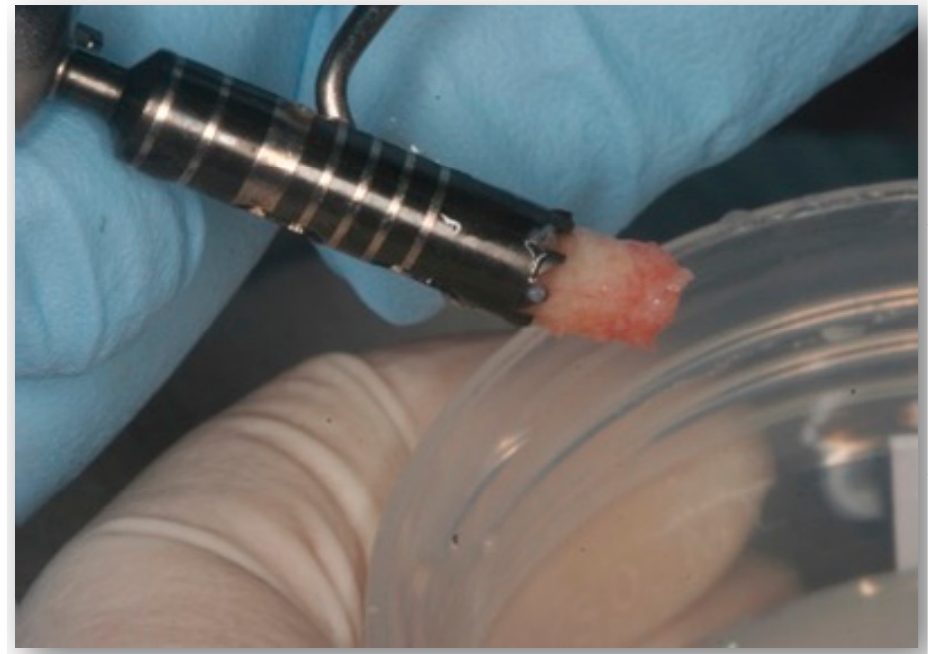
Figure 2. Dentin extracted and removed from the 3.0 trephine with a probe and placed in a sterile container with 80% diluted formaldehyde.